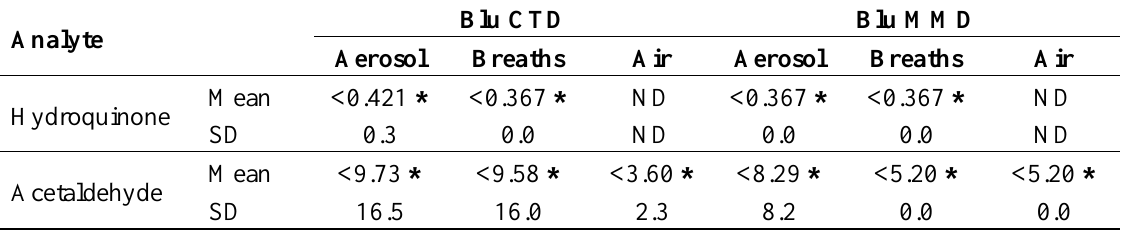
Table 4. Hydroquinone and acetaldehyde in exhaled aerosol, breaths and room air (µg/session) for blu Classic Tobacco Disposable (blu CTD) and blu Magnificent Menthol Disposable (blu